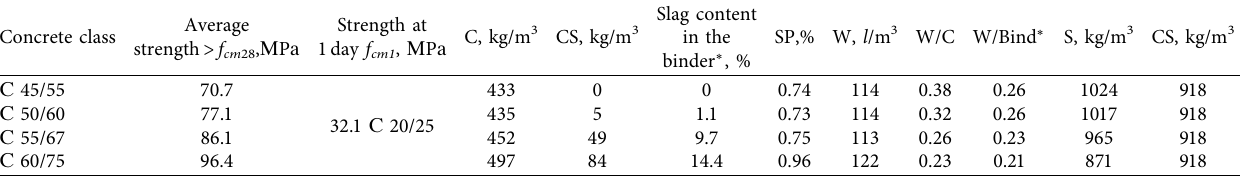
Table 10: Optimization results according to Task 3.